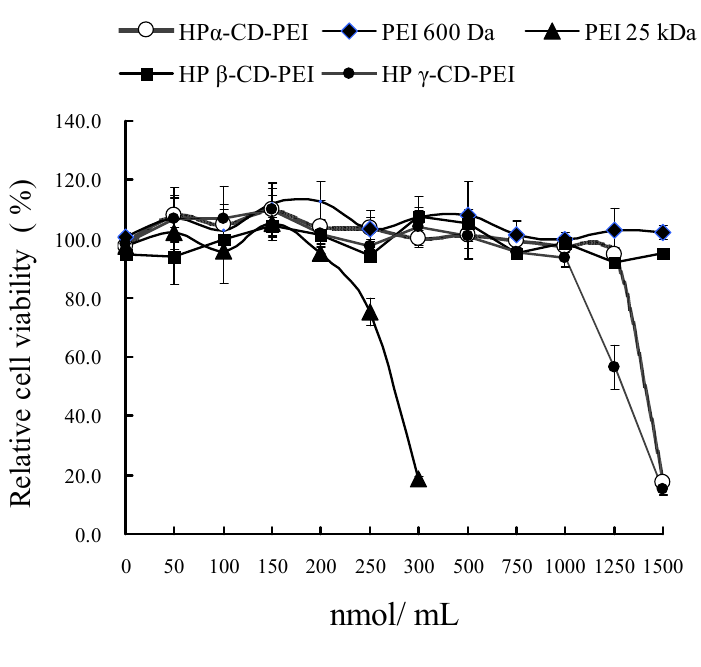
Figure 4. Cell viability of co-polymer/DNA complexes in SK-BR-3